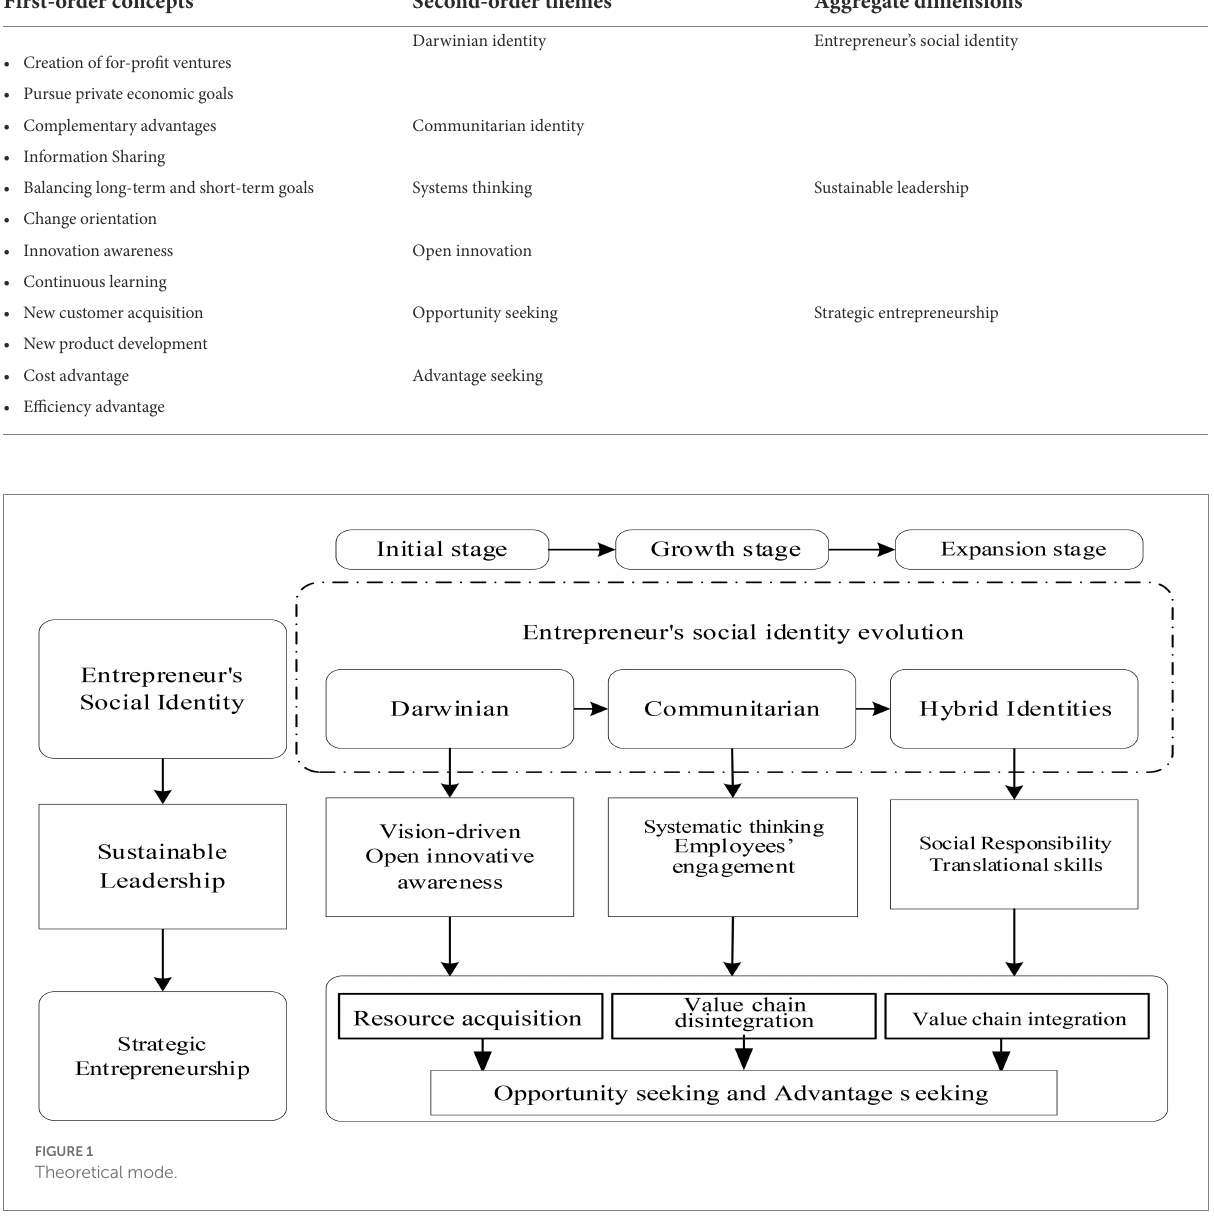
TABLE 3 Example of partly aggregate dimension generated after axis coding. First-order